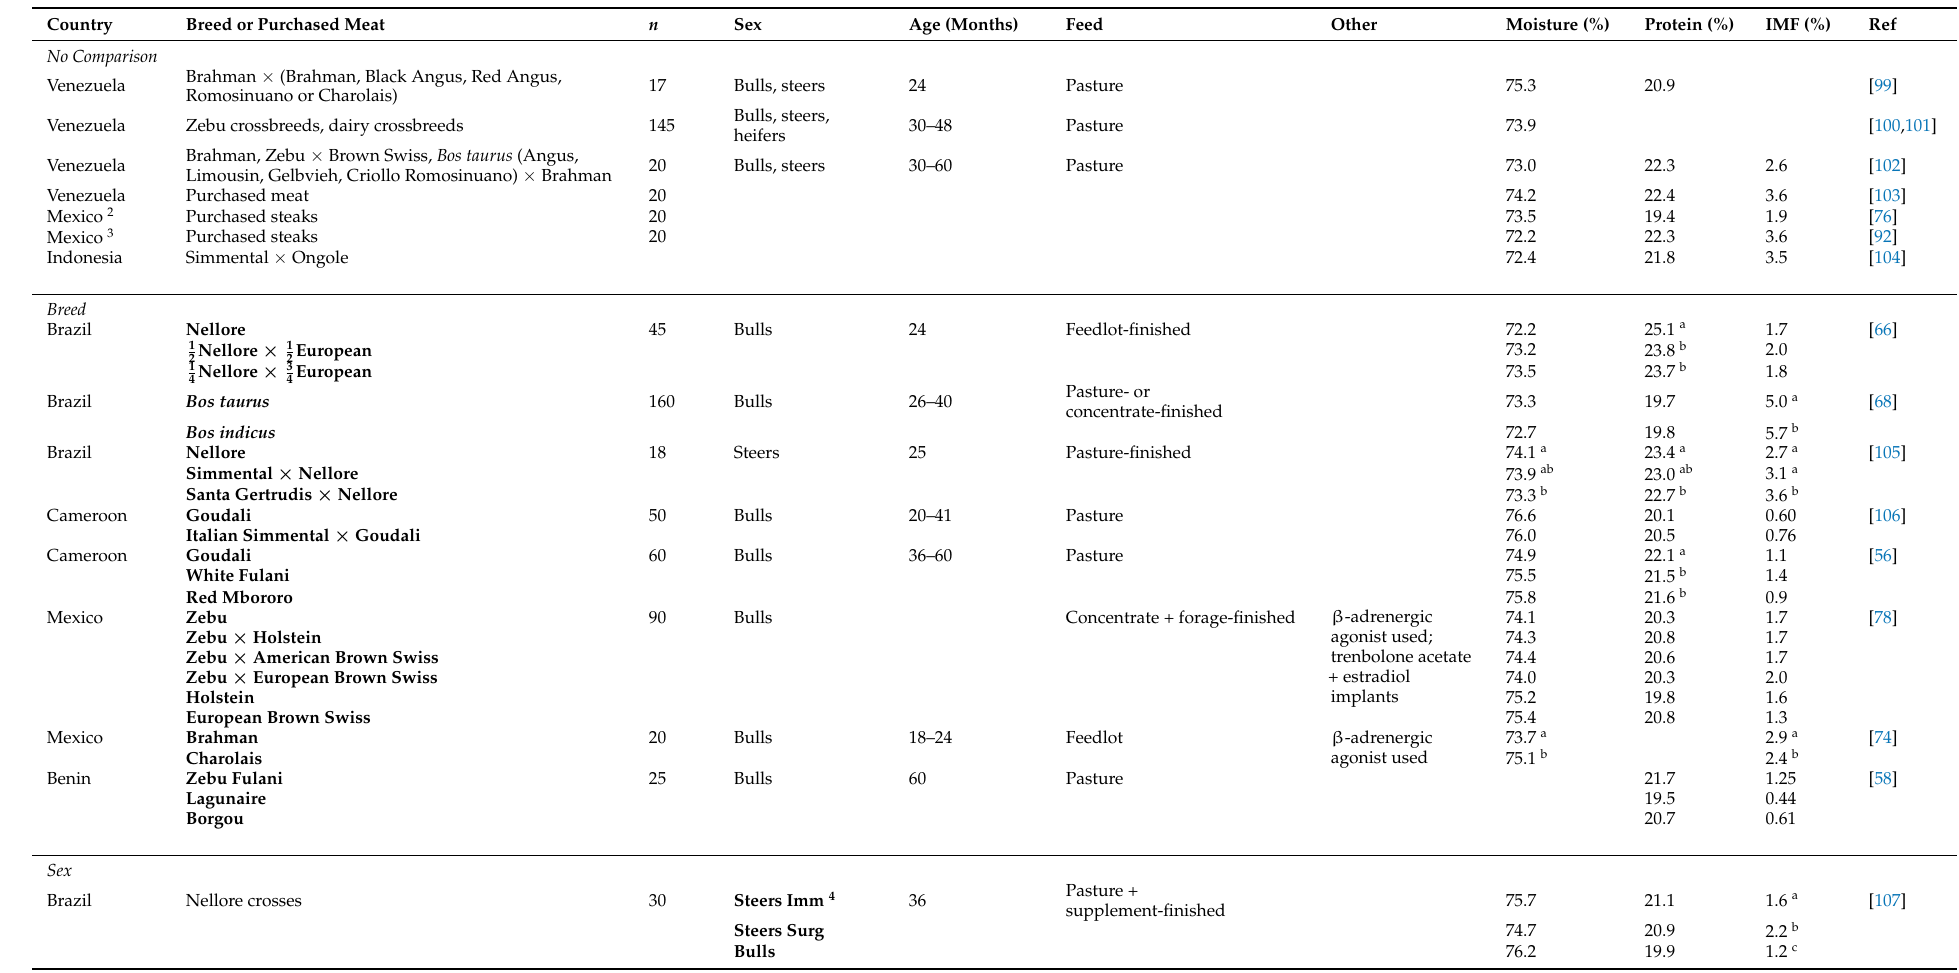
Table 2. Research on the impact of production factors, quality grade or muscle (treatments under study in bold) on the moisture, fat and protein in meat from beef raised in tropical environments.